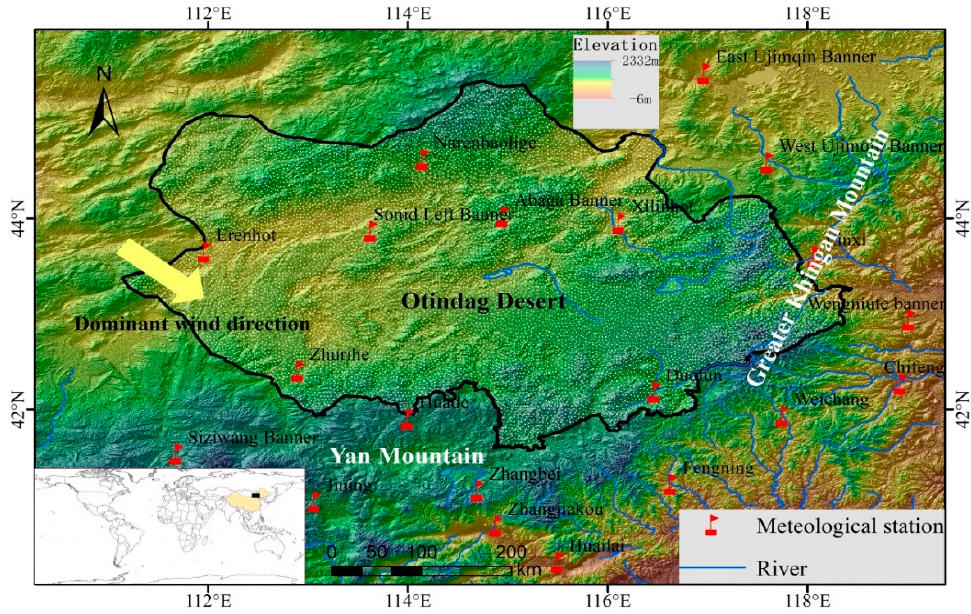
Figure 1. Location map of the Otindag Desert and weather stations. Detailed information about the 20 weather stations is in Table S1.